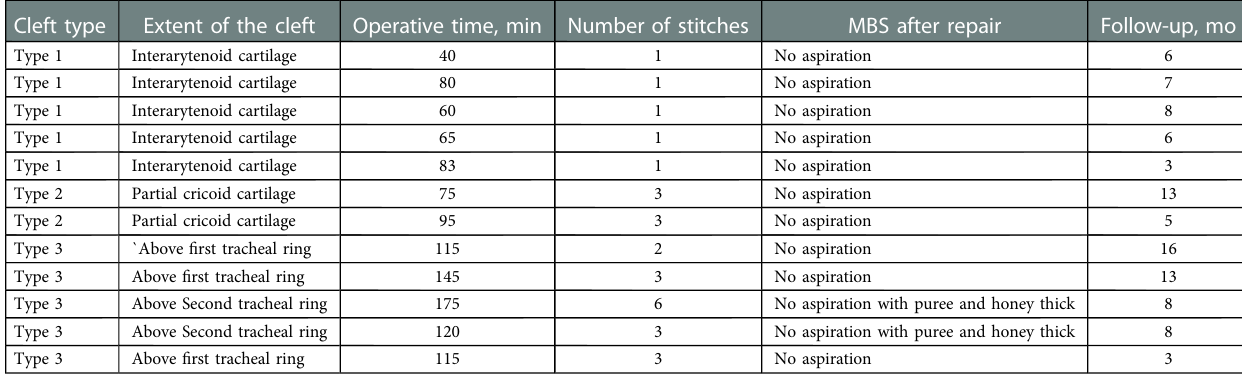
TABLE 2 Endoscopic percutaneous repair and